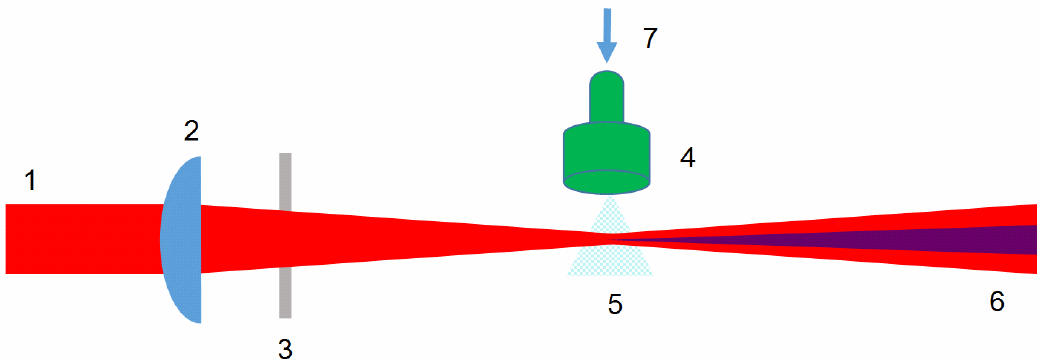
Figure 3. Schematic of the HHG EUV source: (1) input laser pulse; (2) focusing lens; (3) entrance windows with anti-reflective (AR) coating; (4) gas nozzle; (5) HHG EUV source; (6) EUV and laser output to monochromator; and (7) gas input pipe.